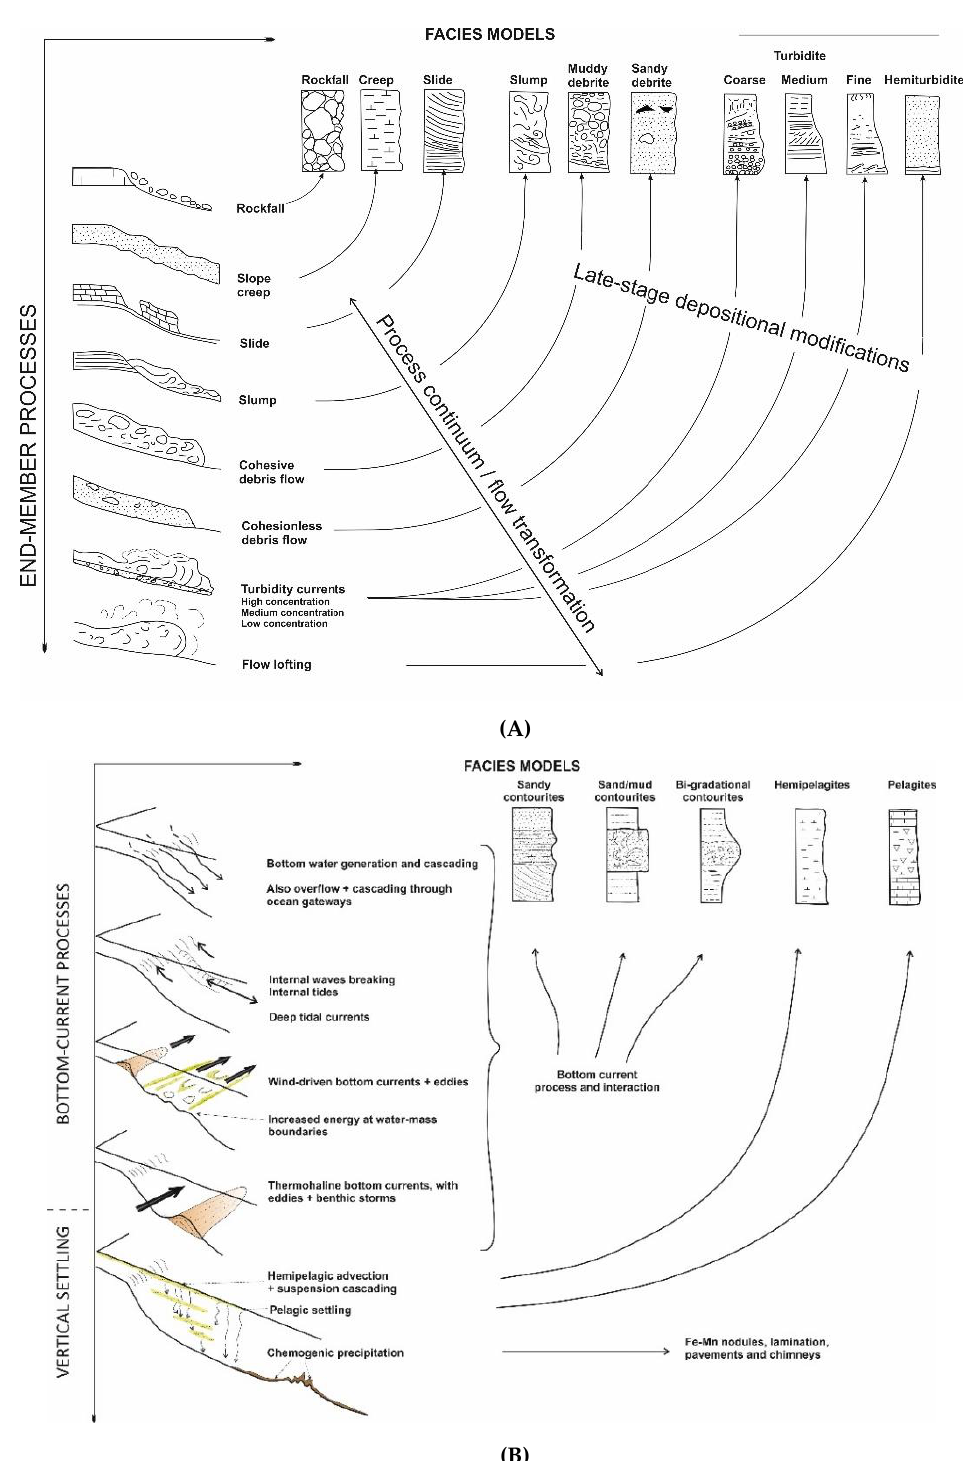
Figure 1. Processes and facies in deep-water sedimentary systems. ( A ) Downslope, Modified from [4]; ( B ) Alongslope and vertical